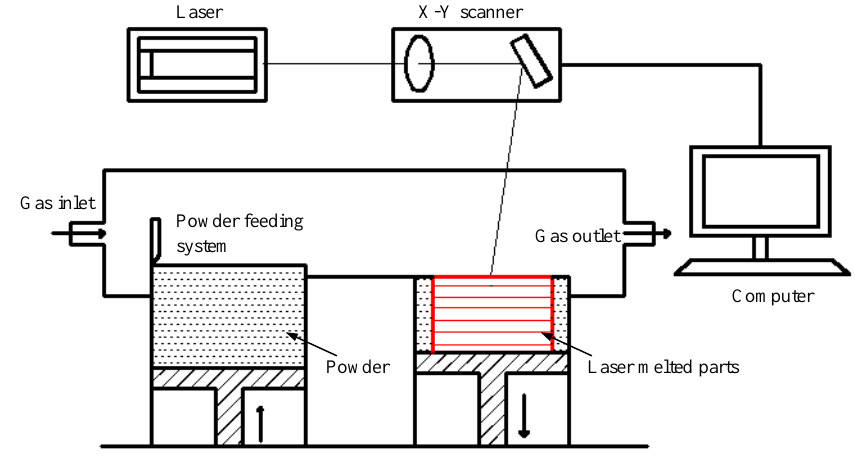
Figure 8. Schematic of laser-melting system.